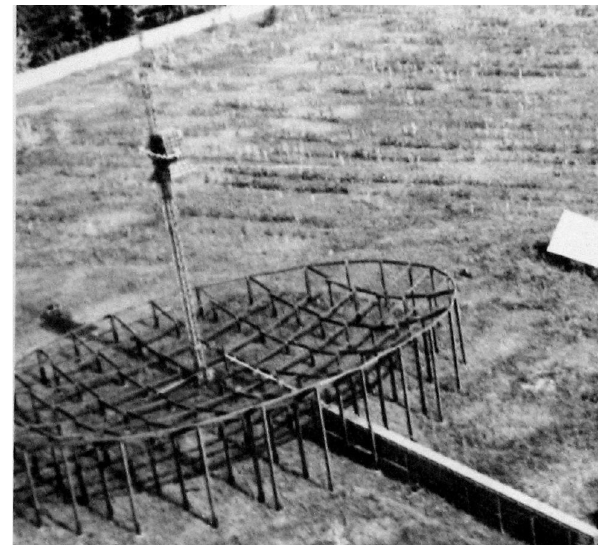
Figure 2. The first parabolic antenna 30m in